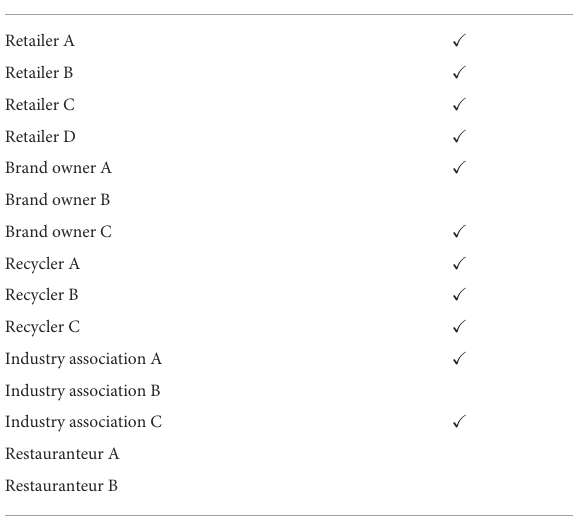
TABLE 6 Stakeholder plastics pact membership as of October 2021. Plastics pact